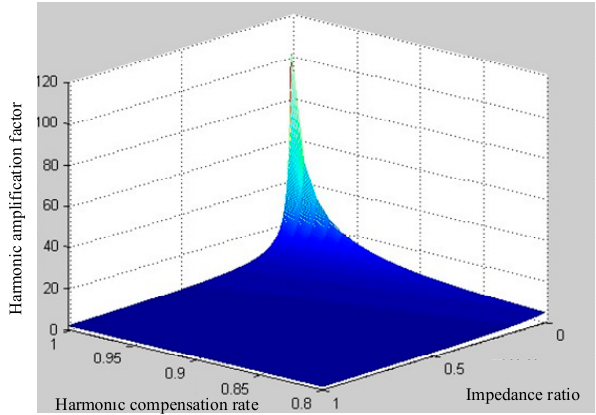
Figure 7. Three-dimensional relationship diagram of the harmonic magnification, harmonic compensation rate, and impedance ratio.